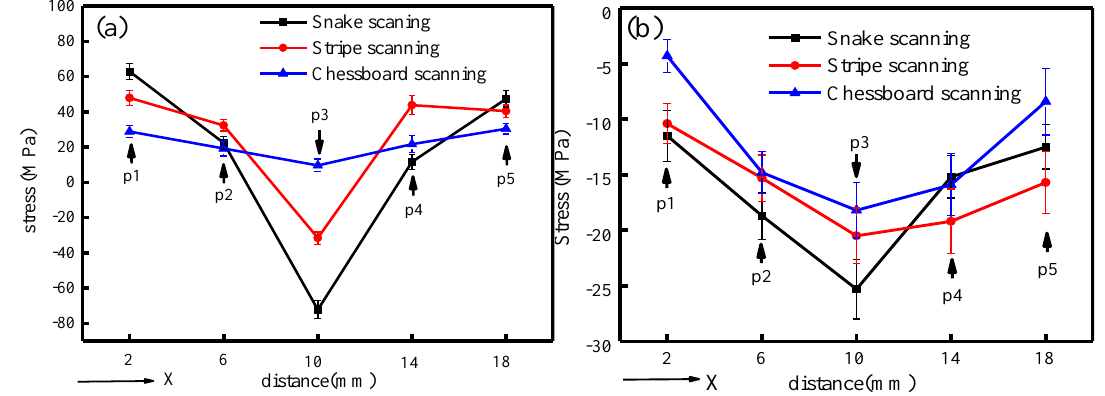
Figure 6. Residual stress distribution of SLMed René 104 superalloy sample along the X-direction in the X–Y plane; ( a ) normal stress; and ( b ) shear